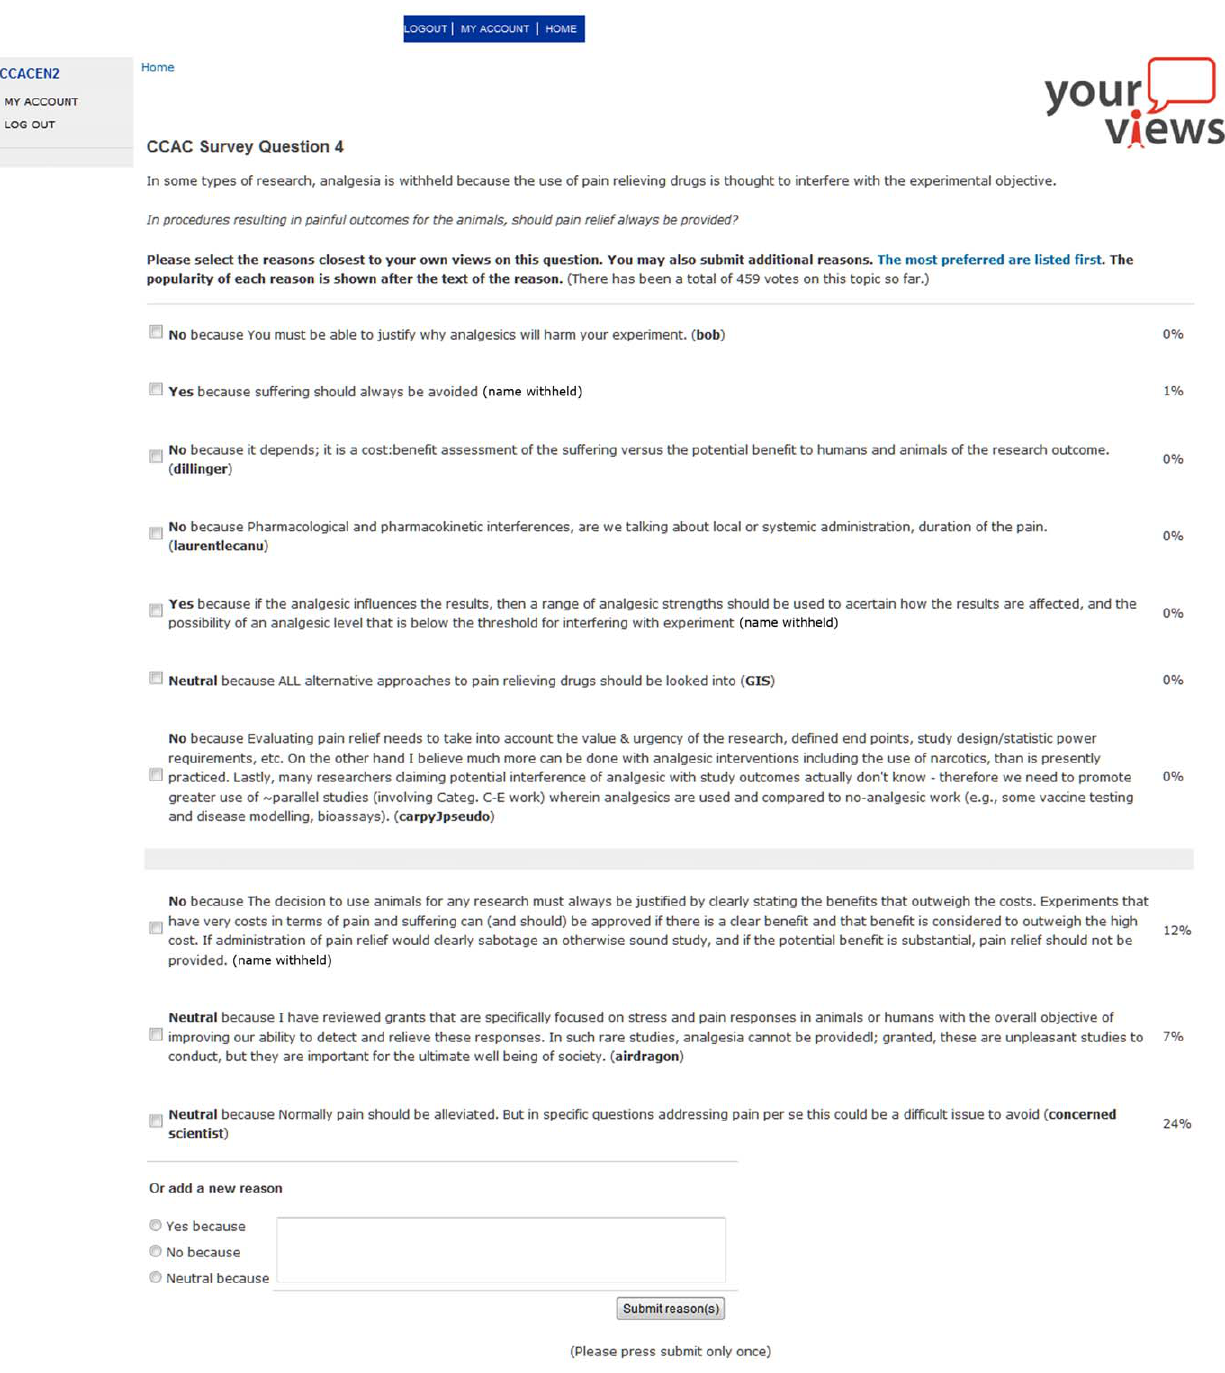
Figure 1. Screenshot of N-reasons interface for survey Q4. Some reasons are omitted; some participant pseudonyms are withheld to maintain participant confidentiality.